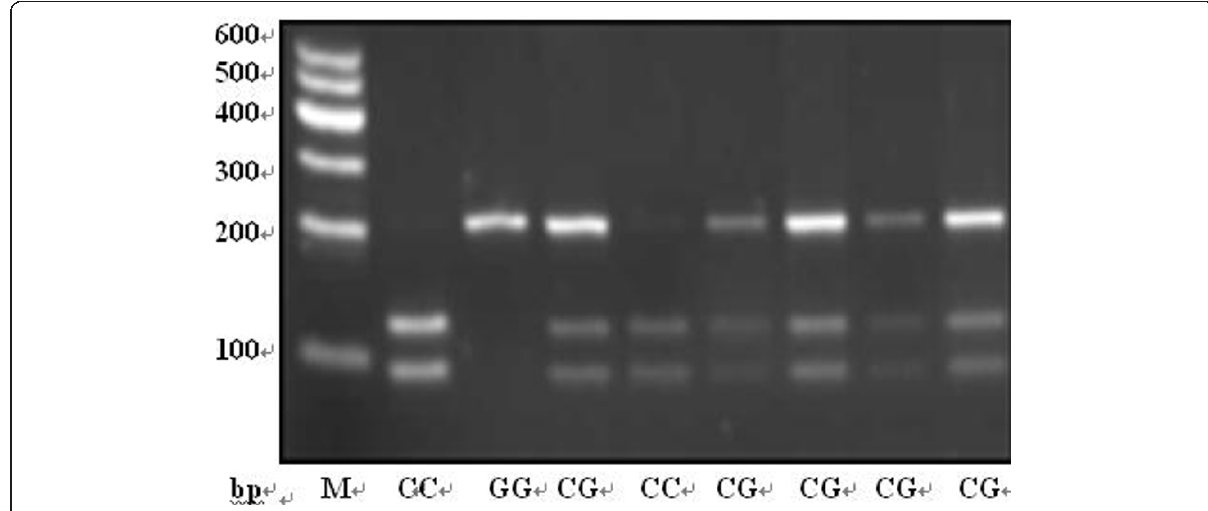
Figure 2 The genotypes of rs9904341 by PCR-RFLP .